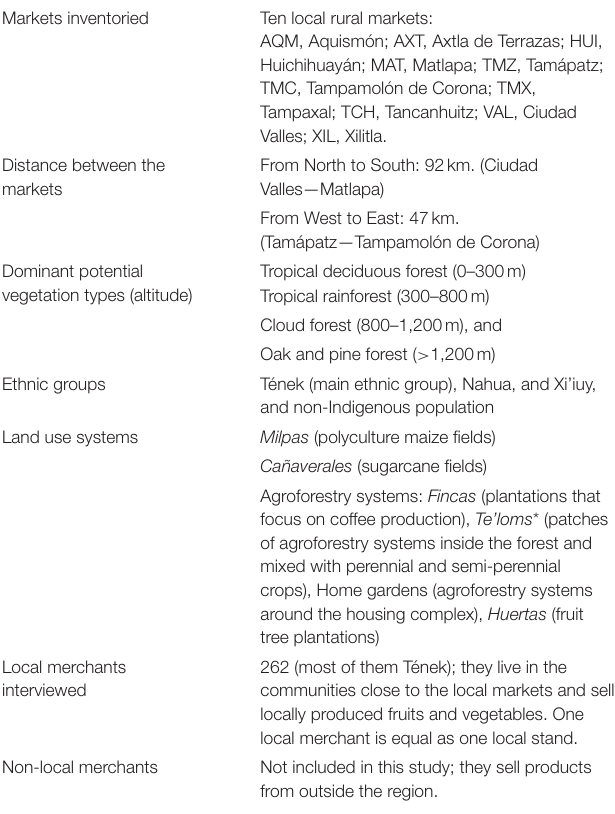
TABLE 1 | Characteristics of the research